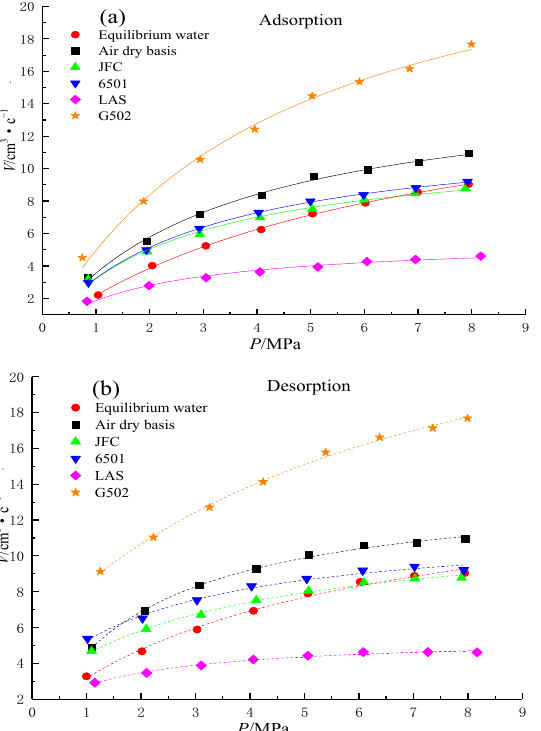
Figure 13. Methane adsorption/desorption fitting curves of samples with different wettabilities: ( a ) adsorption; ( b ) desorption. ( a ) adsorption; ( b )